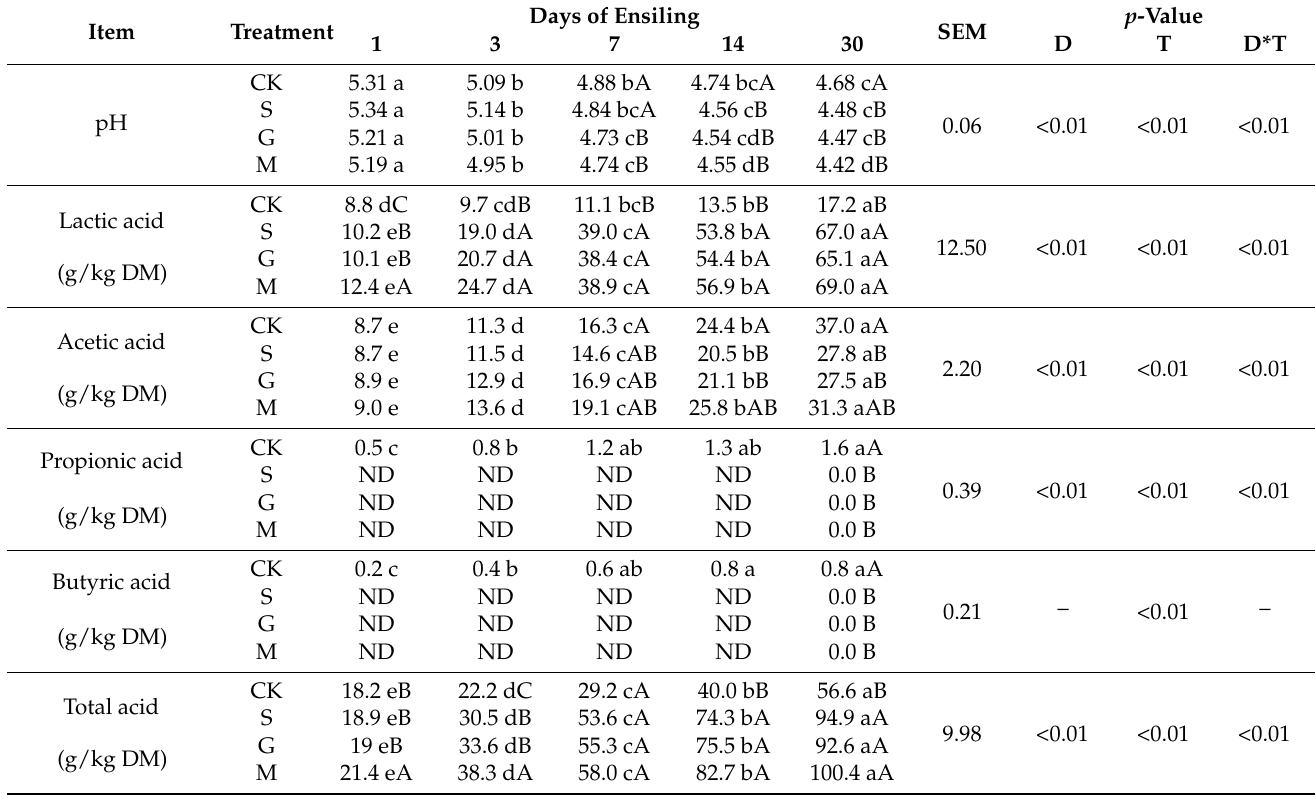
Table 1. Fermentation quality of stylo